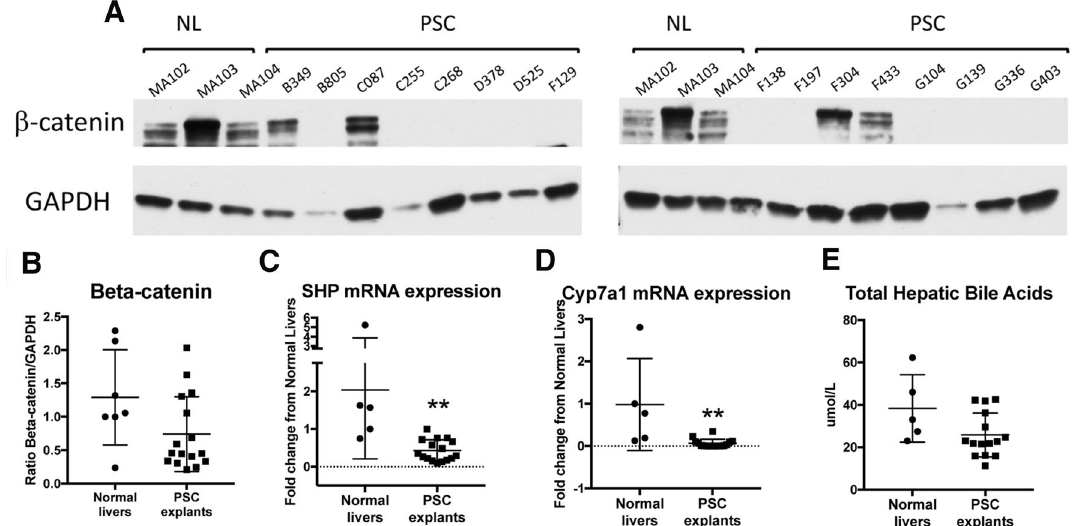
Figure 2. β-catenin is absent in a majority of explanted livers from PSC patients and correlates with decreased Cyp7a1 mRNA expression. ( A ) Representative WB of 16 livers explanted at the time of transplant for PSC shows loss of β-catenin in the majority of patient samples. β-catenin bands were standardized to GAPDH to control for the possibility of protein degradation due to disease. ( B ) Quantification of WBs by densitometry confirms that total β-catenin protein is decreased in most PSC samples compared to NL. ( C ) Expression of SHP mRNA decreases in livers explanted for PSC compared to NL. ( D ) Cyp7a1 mRNA expression is significantly decreased in PSC explants. ( E ) Levels of hepatic bile are unchanged between NL and PSC explants. ** p < 0.01. For A and B, n = 7 NL, while for C-E, n = 5 NL due to insufficient quantity of